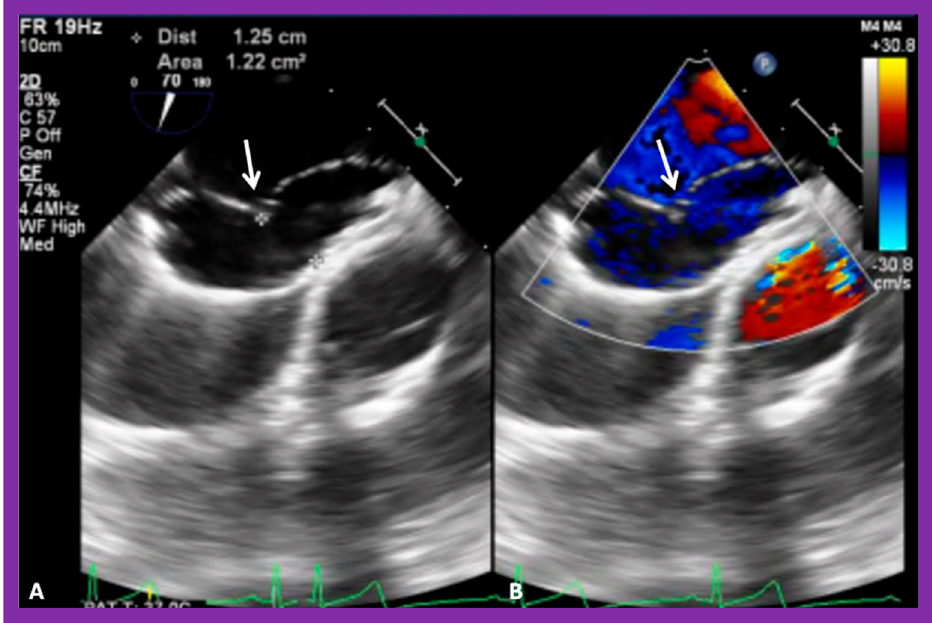
Figure 24. Transesophageal echocardiogram demonstrating static sizing balloon. Note waisting of a sizing balloon (arrow in both ( A , B )). Note that there is no evidence for any shunt in ( B ).